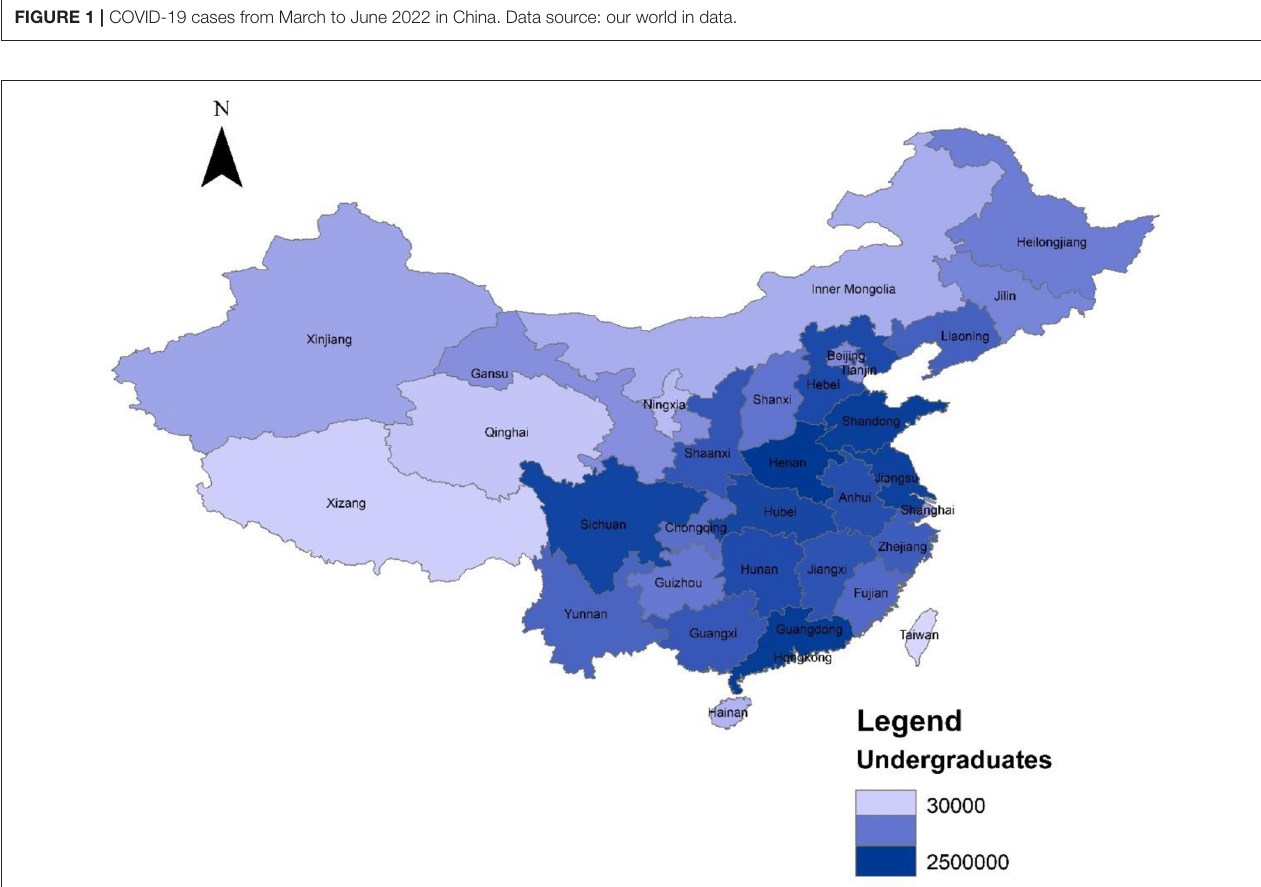
FIGURE 2 | Distribution of undergraduates in China. Source: collected from Ministry of Education of the People’s Republic of China and designed by the authors. The darker the color, the greater the number of undergraduates, and vice